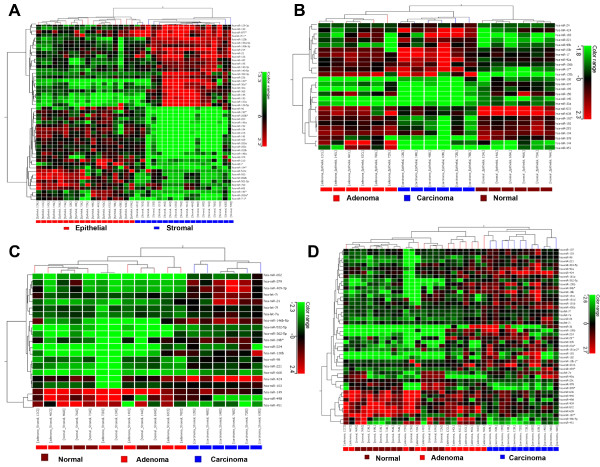
Cell type-specific miRNA expression profiles. A) hierarchical clustering of 51 miRNA expression profiles in LCM selected epithelial and stromal cells from 18 colorectal tissues (n = 6 normal, n = 6 adenomas and n = 6 carcinomas); B) hierarchical clustering of 26 miRNA expression profiles in LCM selected epithelial cells from the colorectal tissues; C) hierarchical clustering of 21 miRNA expression profiles in LCM selected stromal cells from the colorectal tissues and D) hierarchical clustering of 46 miRNA expression profiles in the mixed cell types (epithelial and stromal cells) from the colorectal tissues. The mean signal from biological replicate samples was used for the clustering. Colored bars indicate the range of normalized log2-based signals.